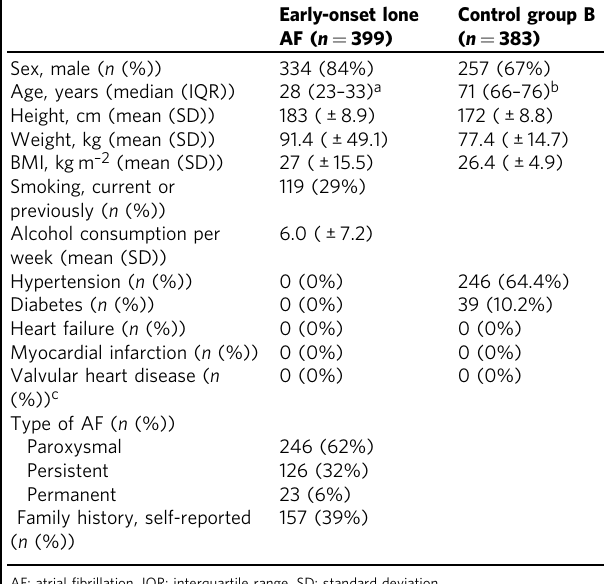
Table 1 Baseline characteristics of the early-onset lone